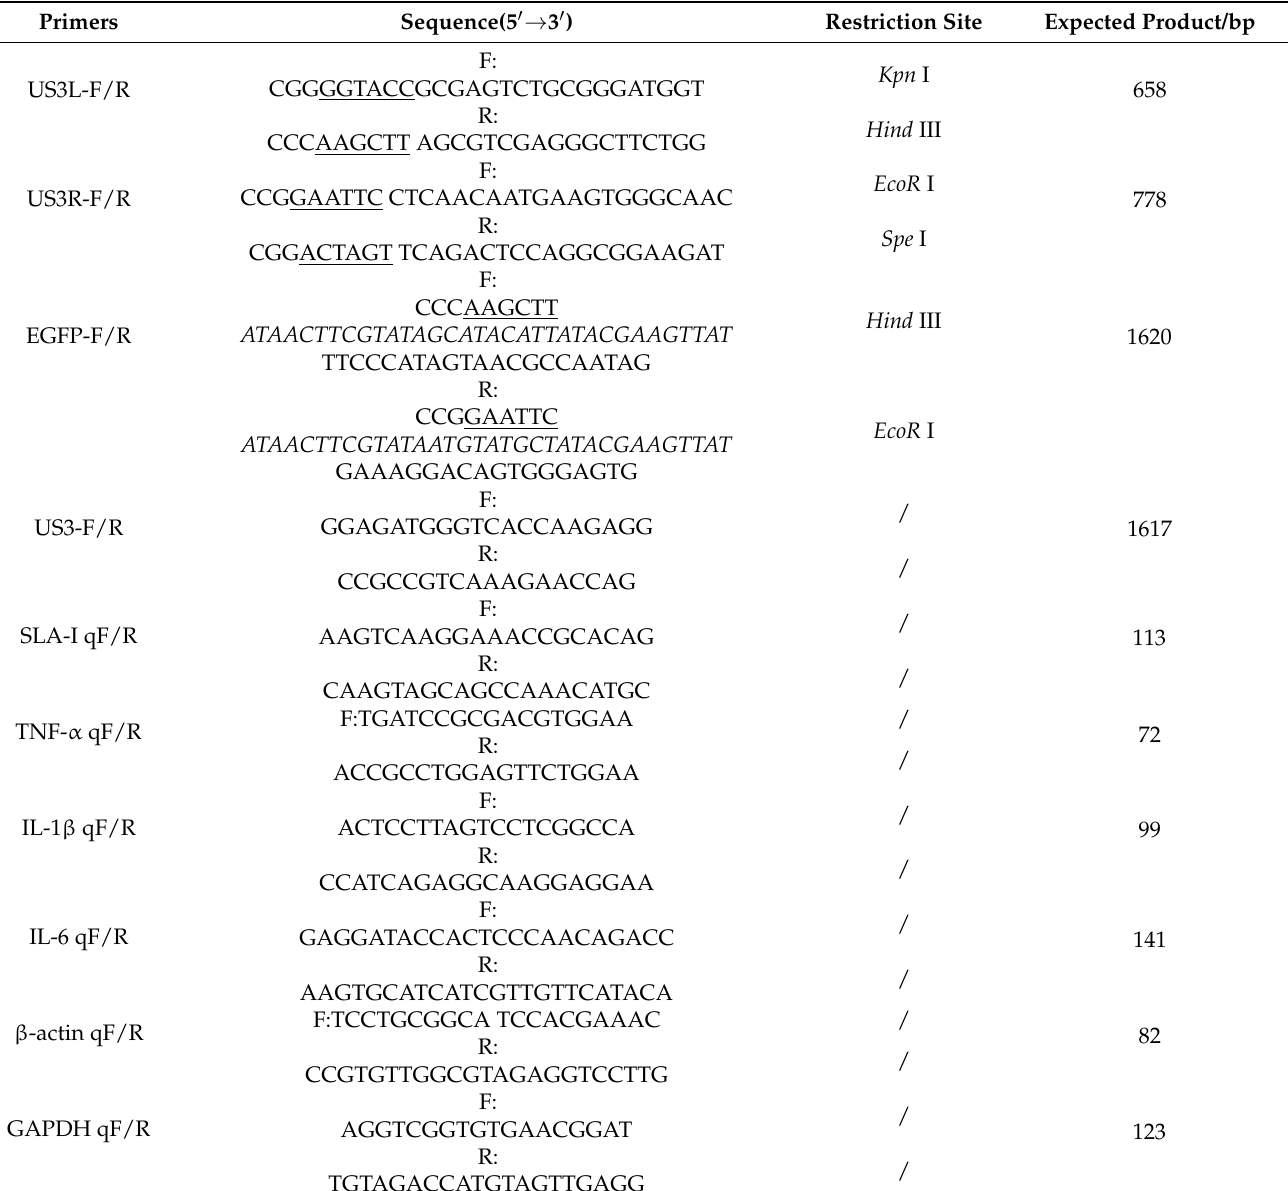
Table 1. Primers that were used in this